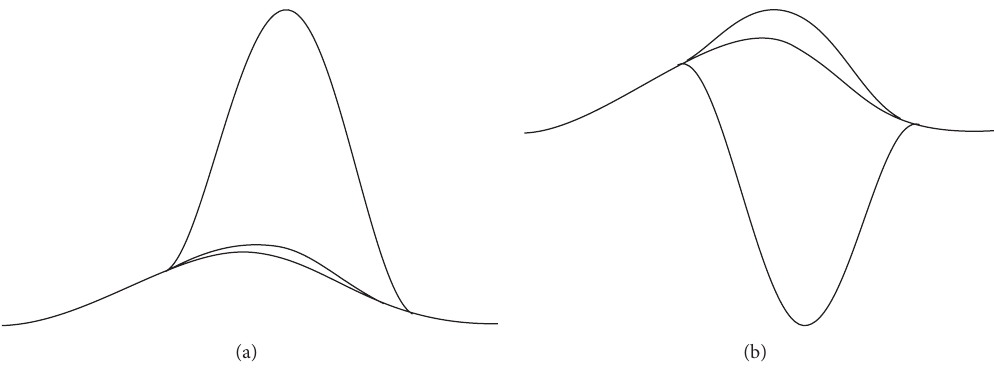
Figure 13: The 1st (a) and the 2nd mode (b) for a noncentrally delaminated